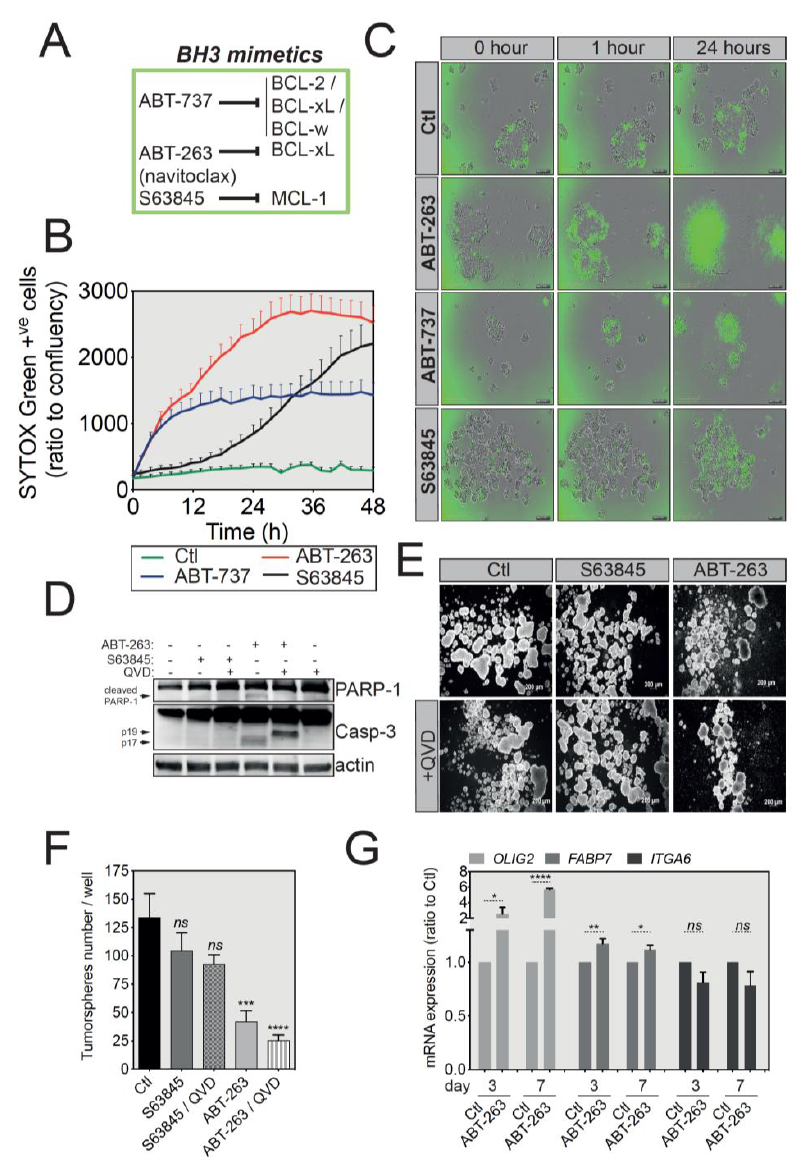
Figure 5 . U-87 MG tumorspheres have an increased sensitivity to ABT-263-induced apoptosis. ( A ) Brief summary of the main BH3 mimetics and their preferential targets. ( B ) IncuCyte imager-based cell death induction analysis of U-87 MG-derived tumorspheres treated with ABT-737, ABT-263 or S63845 as indicated. Induction of apoptosis was assessed by SYTOX Green incorporation into permeabilized dead cells. ( C ) Representative pictures of U-87 MG tumorspheres treated with different BH3 mimetics, while the green signal indicates SYTOX Green-positive apoptotic cells Magnification: 4X. ( D ) Western blot analysis of PARP-1 and caspase-3 protein expression and cleavage following treatment with BH3 mimetics. Full-length blots are presented in Figure S4. ( E ) Representative images of U-87 MG tumorspheres in a long-term survival assay. Briefly, following treatment with the indicated BH3 mimetics, U-87 MG-derived tumorspheres were cultured in fresh medium for another week and imaged. Magnification: 2.5X. ( F ) Quantification of tumorsphere number for the long-term survival assay described in ( E ) (data represent mean with SEM from three independent experiments, one-way ANOVA, ns p > 0.05, *** p ≤ 0.001, **** p ≤ 0.0001). ( G ) qRT-PCR analysis for the GSC signature of U-87 MG tumorspheres treated with ATB-263 (data represent mean with SEM from three independent experiments, one-way ANOVA, ns p > 0.05, * p ≤ 0.05, ** p ≤ 0.01, **** p ≤ 0.0001).